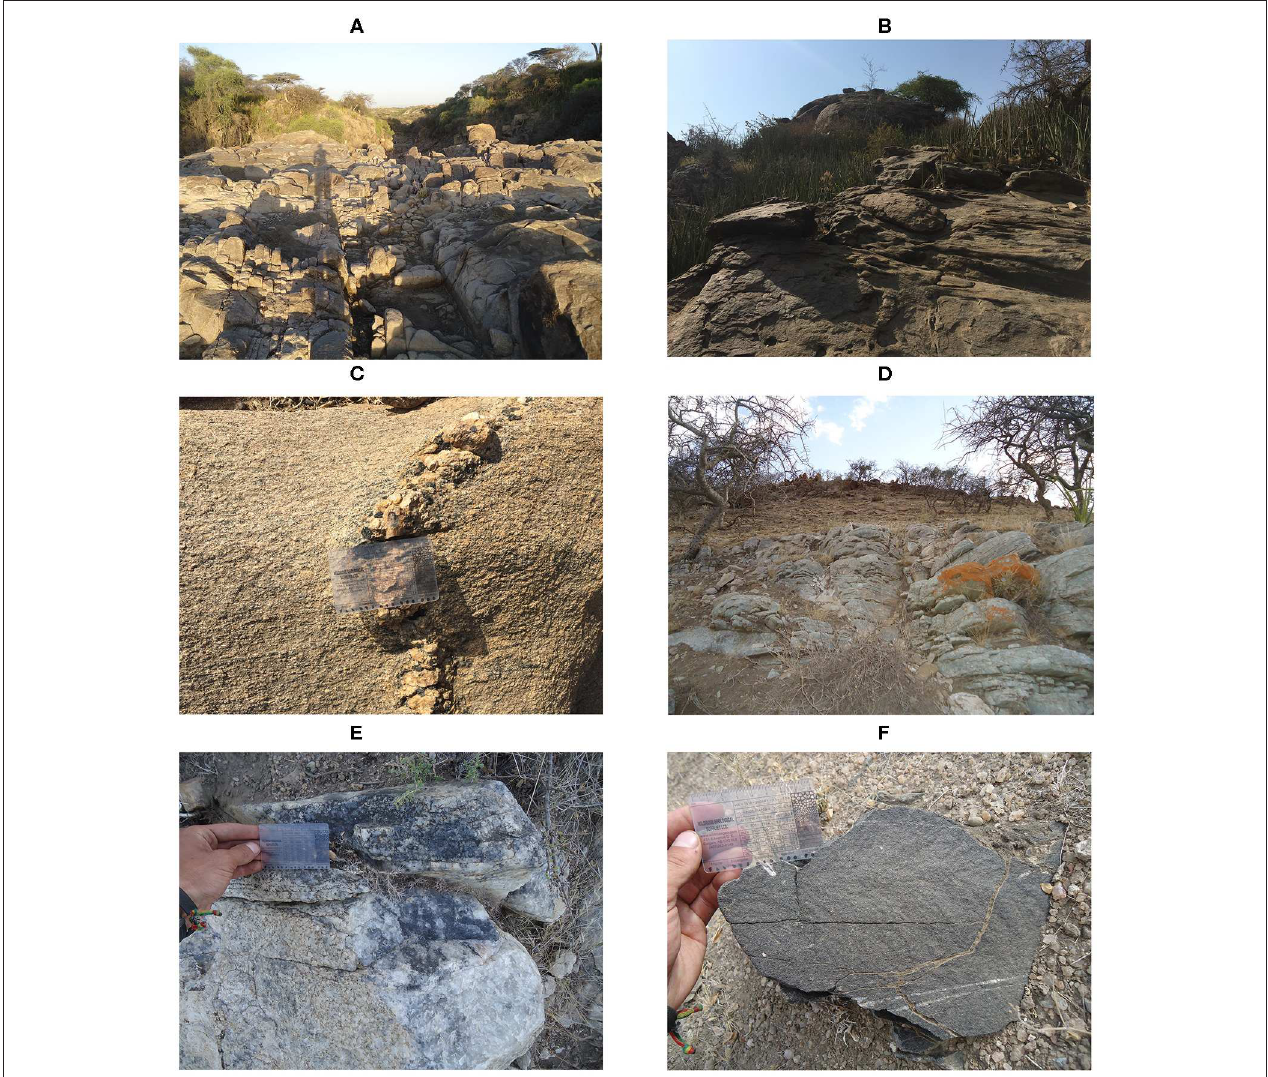
FIGURE 4 | Granite Falls: (A) View east showing jointed granite gneiss forming the riverbed of the seasonal Olduvai River; Kelogi: (B) complexly deformed, weathered, and varnished granite gneiss; (C) close-up of a quartz and mafic vein; Naibor Soit Kubwa: (D) quartzite with foliation planes dipping west overlain by gneiss outcrops; (E) magnetite-rich quartzite on the eastern side of the inselberg; (F) portion of the amphibolite dyke with sub-parallel quartz veins.